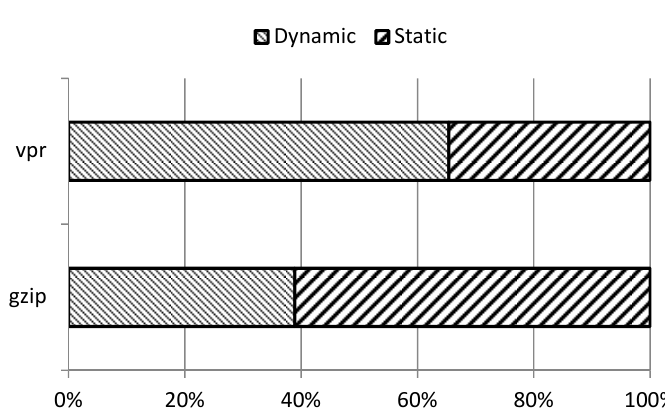
Figure 6. Breakdown of power